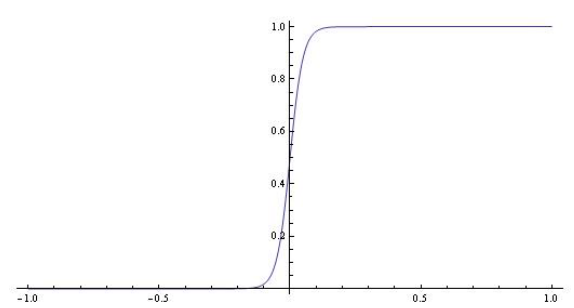
Fig. 3. A logistic function (13) with γ = 0 and reaction rate k = 40